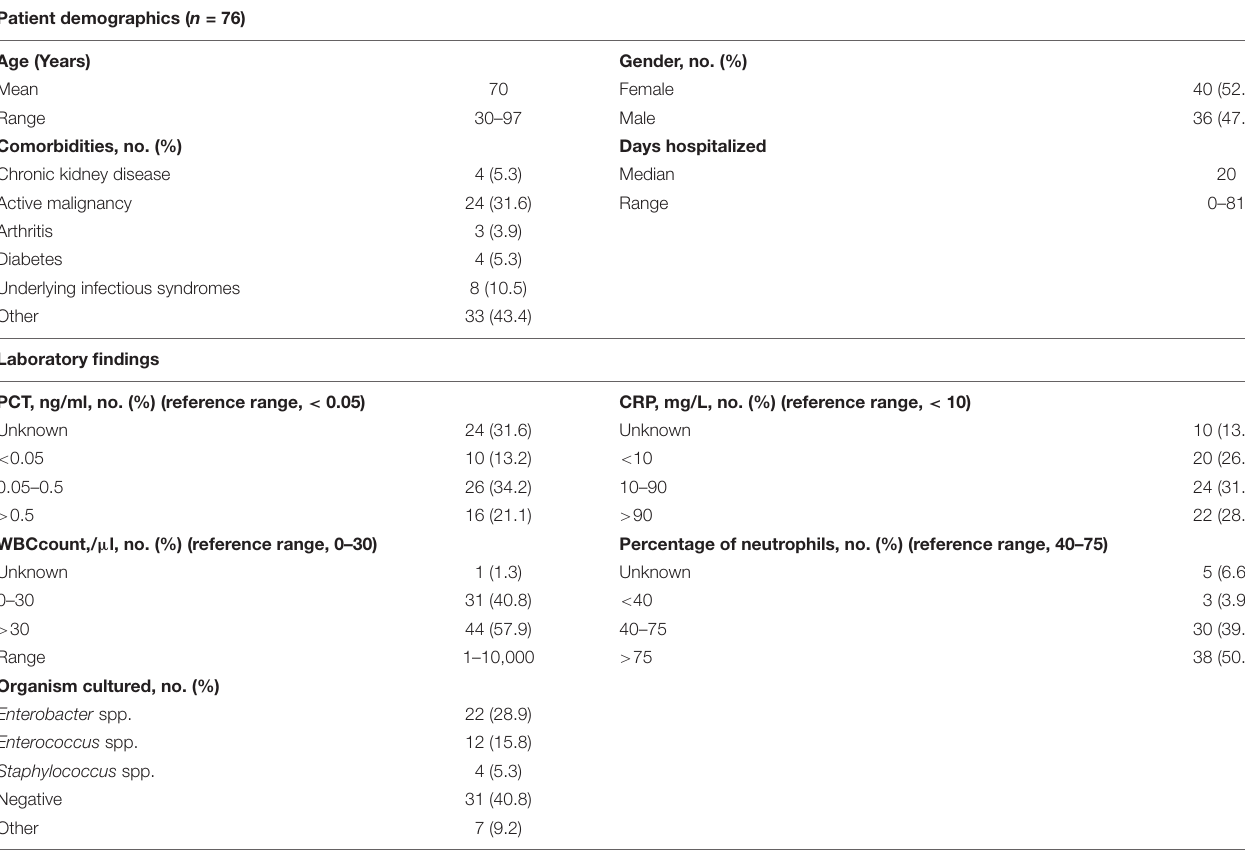
TABLE 1 | Characteristics of patients and laboratory findings.